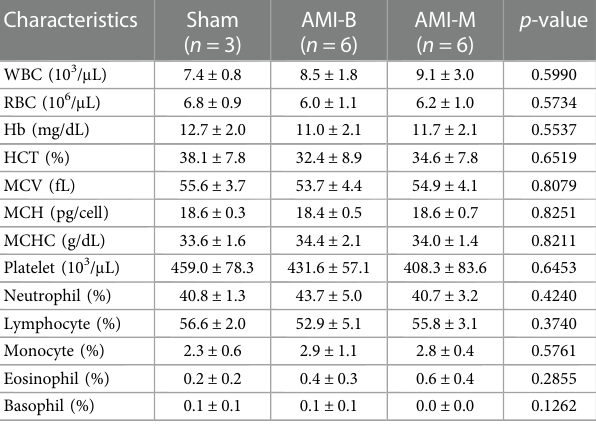
TABLE 1 Hematological characteristics of three groups at